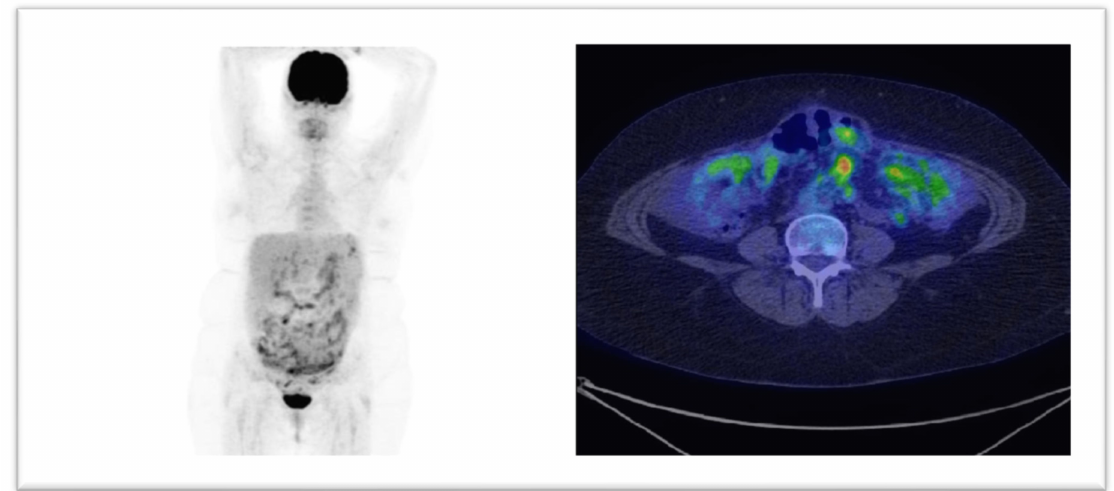
Figure 5. MIP and axial images from a 18F-FDG PET-CT scan, revealing peritoneal carcinomatosis, in patient with a CA-125 serum level of 642 U/mL. After the investigation, the type of chemotherapy was changed (paclitaxel to